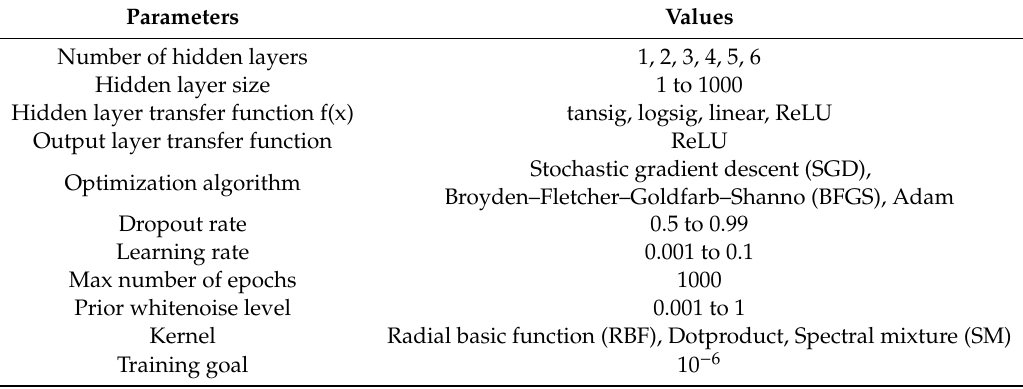
Table 4. The structure of the DKL for predicting multi-ion concentration. Parameters Values Number of hidden